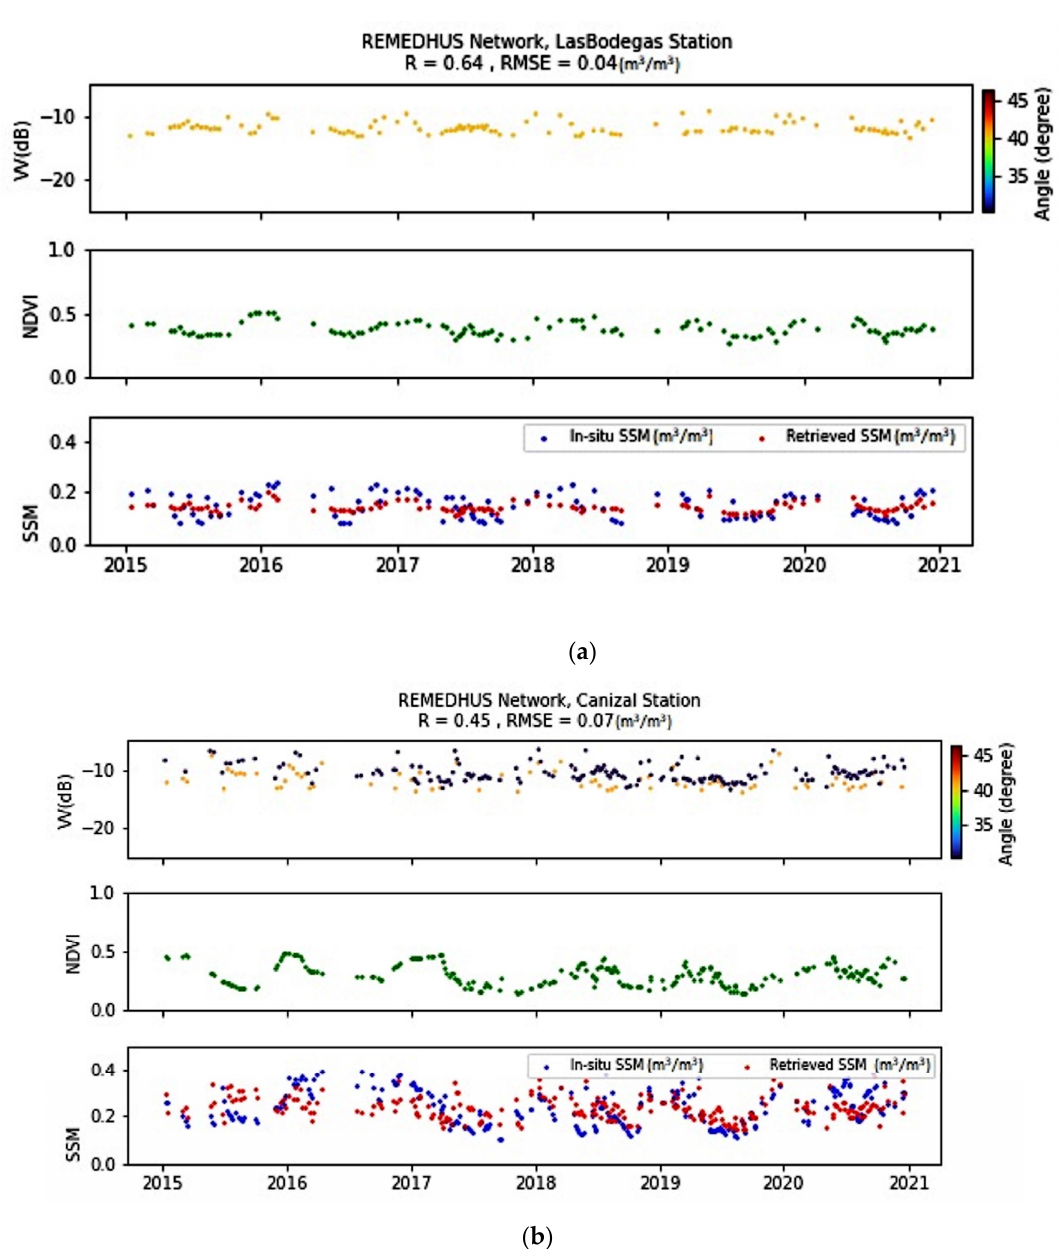
Figure 6. Scatterplots of the temporal evolution of radar signals in VV polarization, NDVI, and the predicted and in situ measurements of soil moisture using the hybrid methods within two stations of the REMEHDUS network: ( a ) LasBodegas station, ( b ) Canizal station.